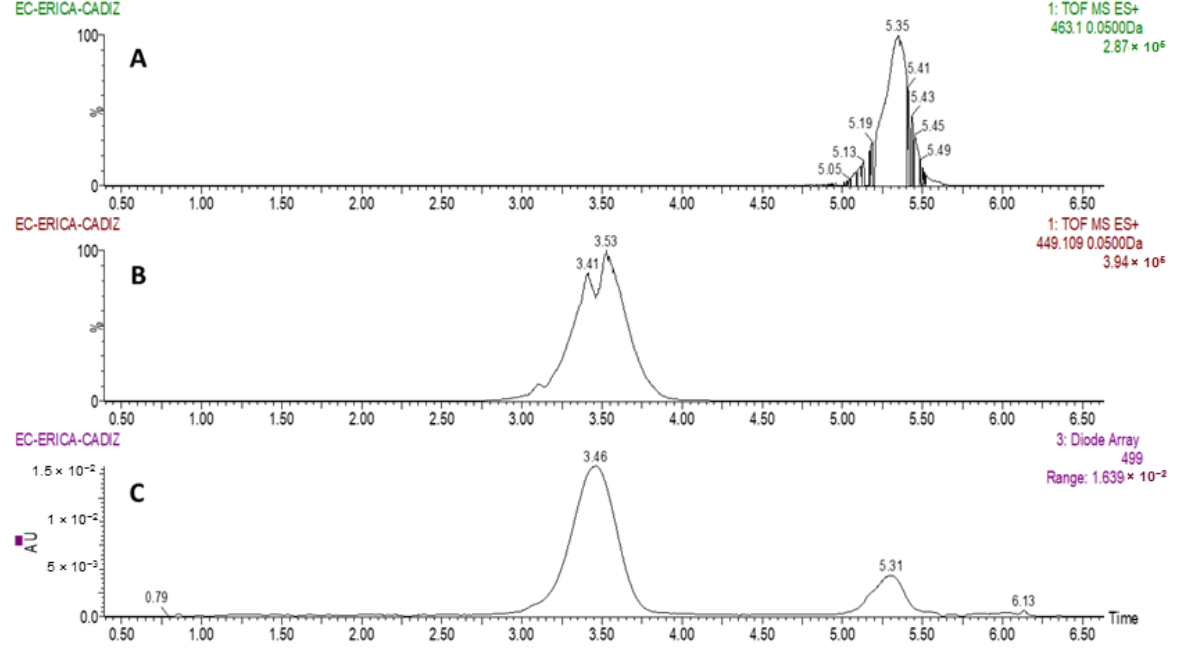
Figure 1. Chromatograms obtained from the analysis of Erica australis flowers by UHPLC-PDA-QToF-MS. ( A ): SIM chromatogram at m / z 463.1 (peonidin 3- O -glucoside); ( B ): SIM chromatogram at m / z 449.1 (cyanidin 3- O -glucoside); ( C ): UV-vis chromatogram at λ 499 nm for anthocyanins.